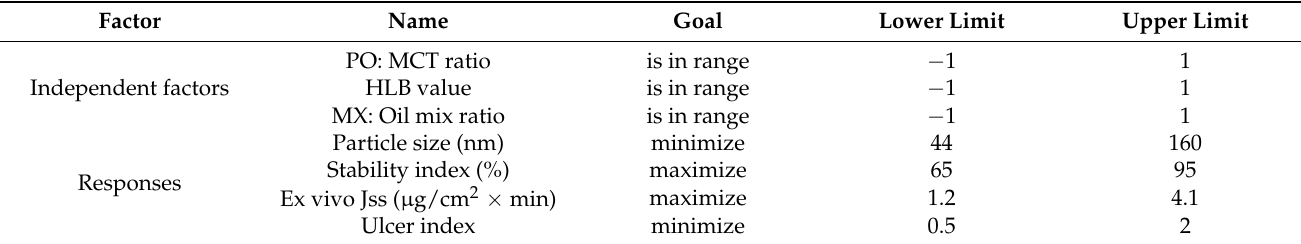
Table 2. Constraints and goals selected for the optimization of MX-PO-SNEDDS